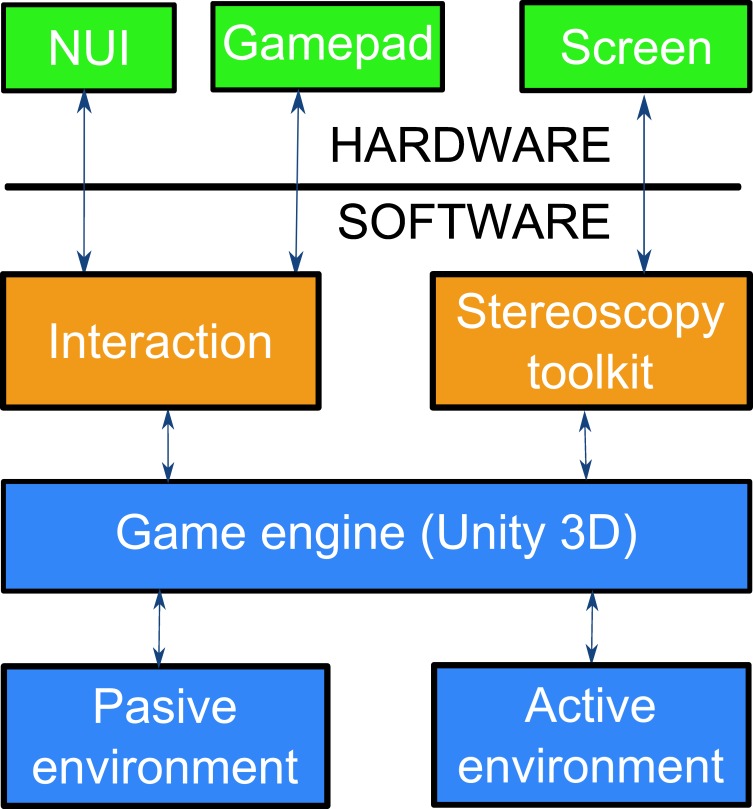
System architecture.